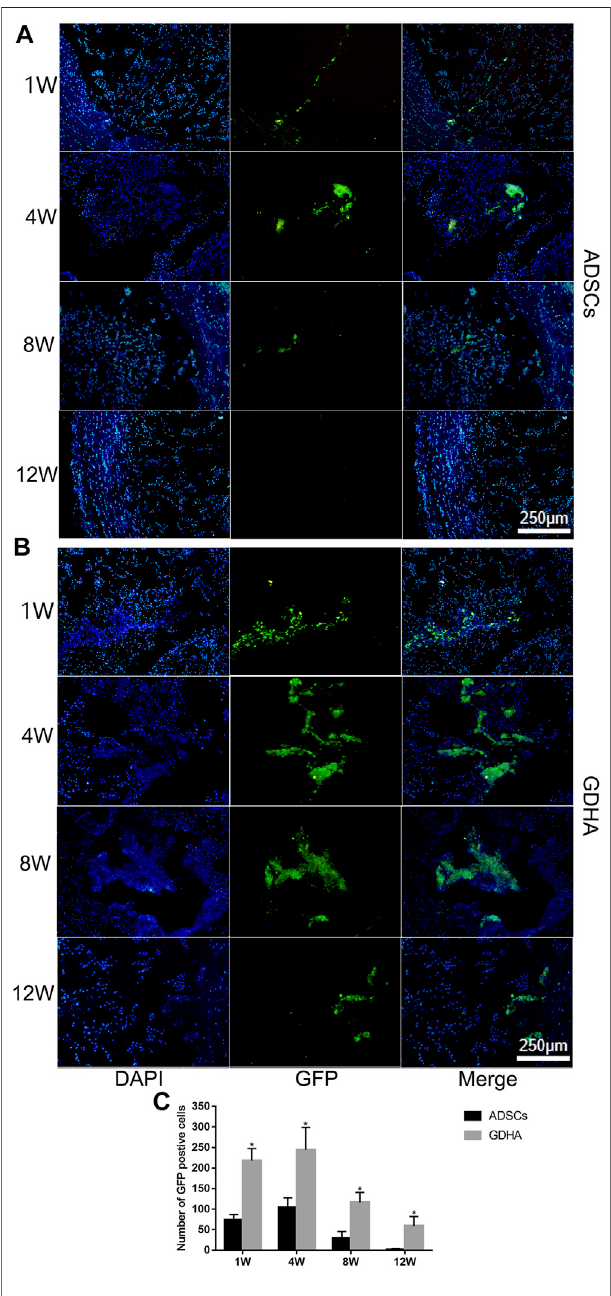
FIGURE 10 | The survival and migration of ADSCs in the tail discs of the ADSC group (A) and GDHA group (B) at 1, 4, 8, and 12 weeks after injection. Datarepresentedmean ± SD( n (cid:2) 5);* p < 0.05, vs.sham group; # p < 0.05,vs. control group; & p < 0.05, vs. ADSC group; $ p < 0.05, vs. GHD group. Scale bar (cid:2) 250 μ